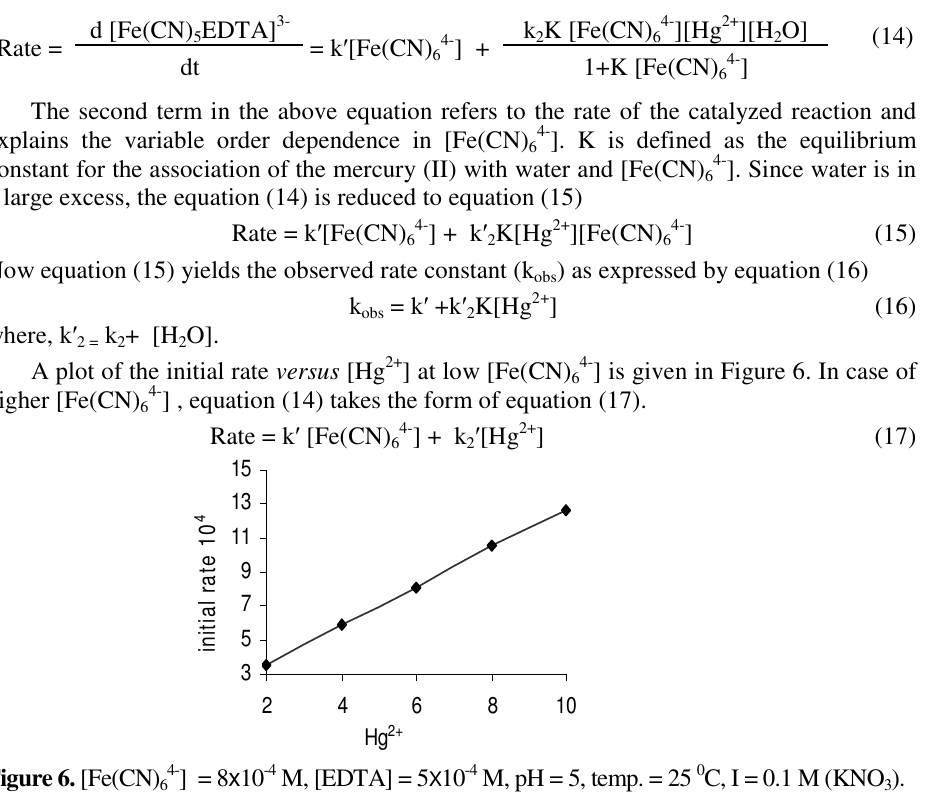
) as a function of [Hg 2+ ] at low [Fe(CN) 64- ] is listed i